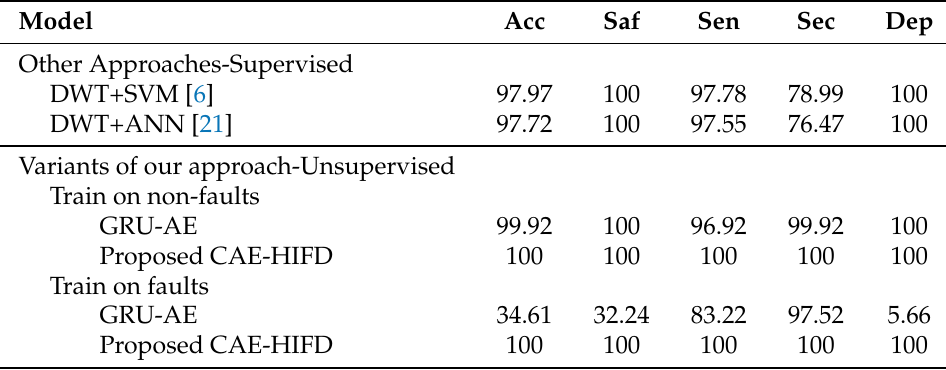
Table 3. Comparison of CAE-HIFD with other HIF detection